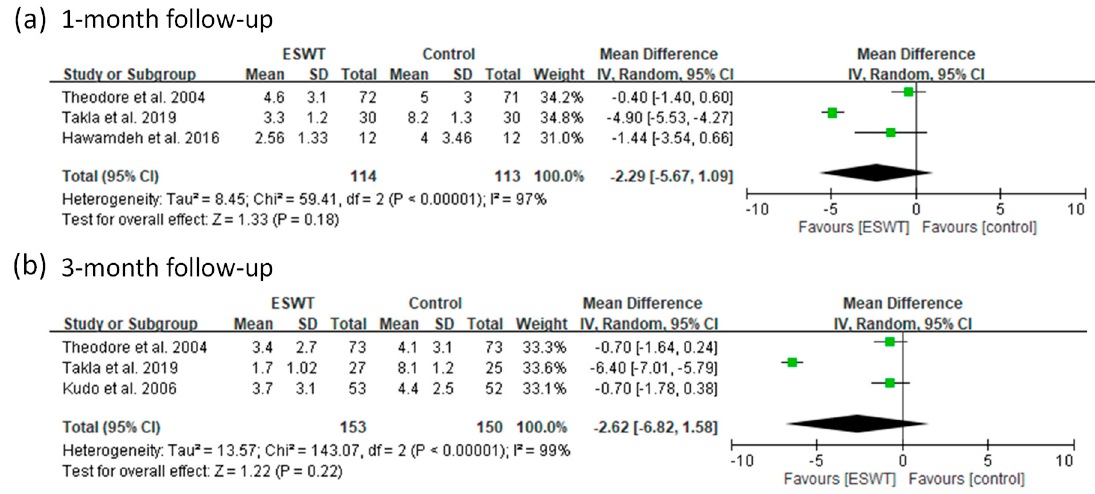
Figure 7. Forest plots of visual analog scale (VAS) scores in high-energy ESWT and placebo-controlled groups at 1-month ( a ) and 3-month ( b ) follow-ups.